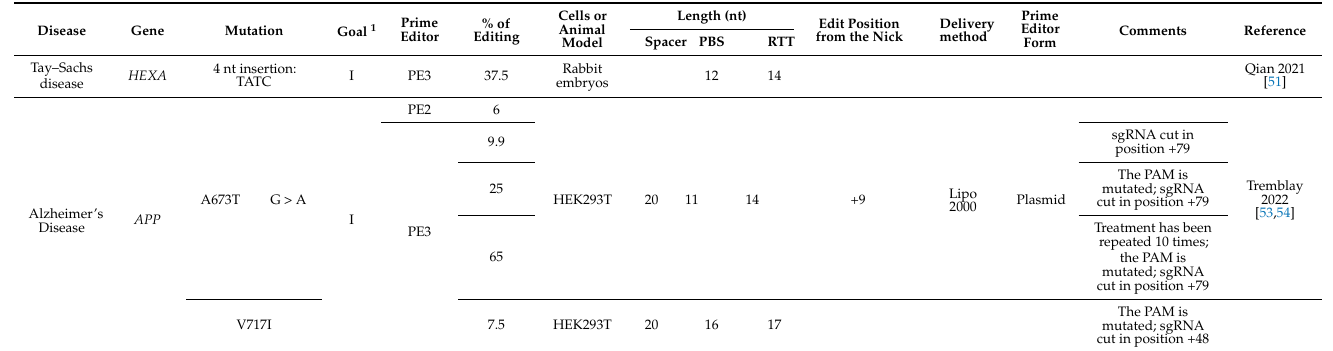
Table 6. Prime editing studies on correcting or introducing genetic mutations causing neurodegener- ative